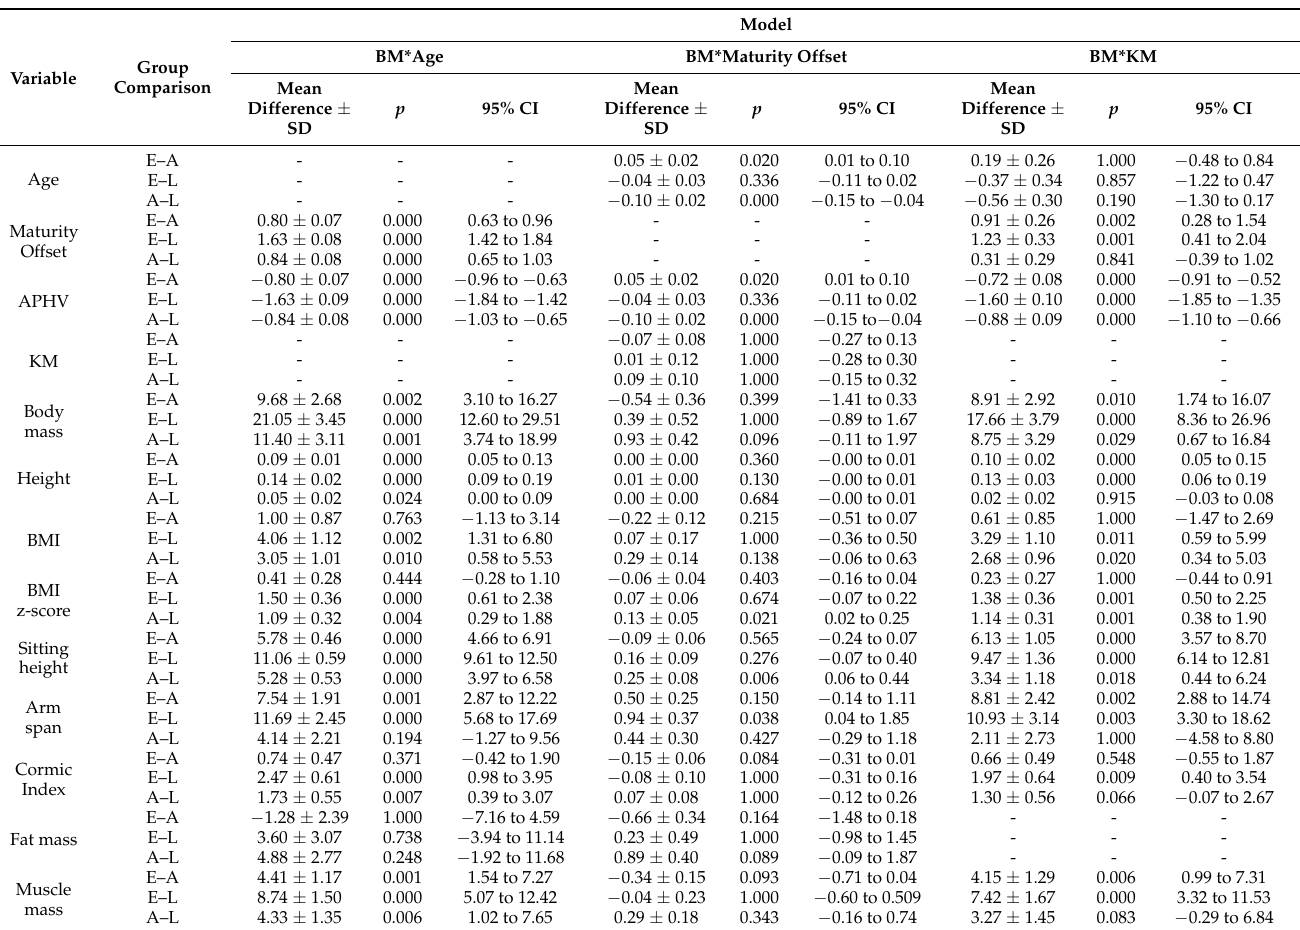
Table 3. Post hoc comparison between biological maturation groups after ANOVA analysis as a function of the covariates age, maturity offset and KM score, for kinanthropometric